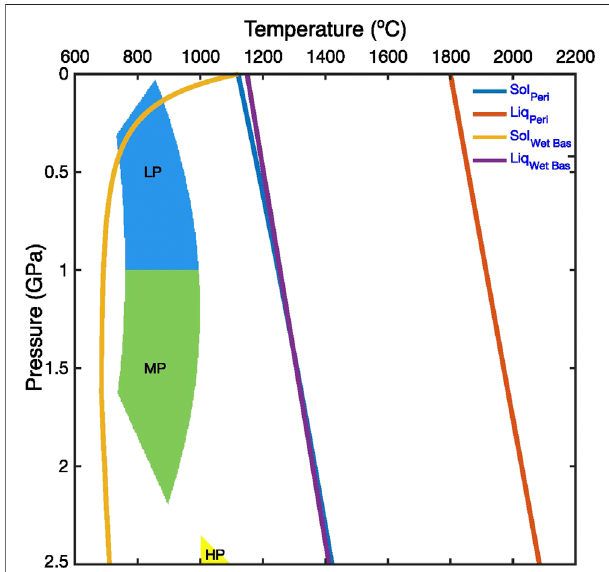
FIGURE 2 | Pressure and temperature conditions ofLow-Pressure (LP), Medium-Pressure (MP) and High-Pressure (HP) tonalite-trondhjemite- granodiorite formation (Reproduced from Moyen (2011) and Jain et al. (2019) under the Creative Commons CCBY license). The solidii and liquidii for mantle peridotite and hydrous basaltic crust (Sizova et al., 2015) are also shown. See Appendix for details.